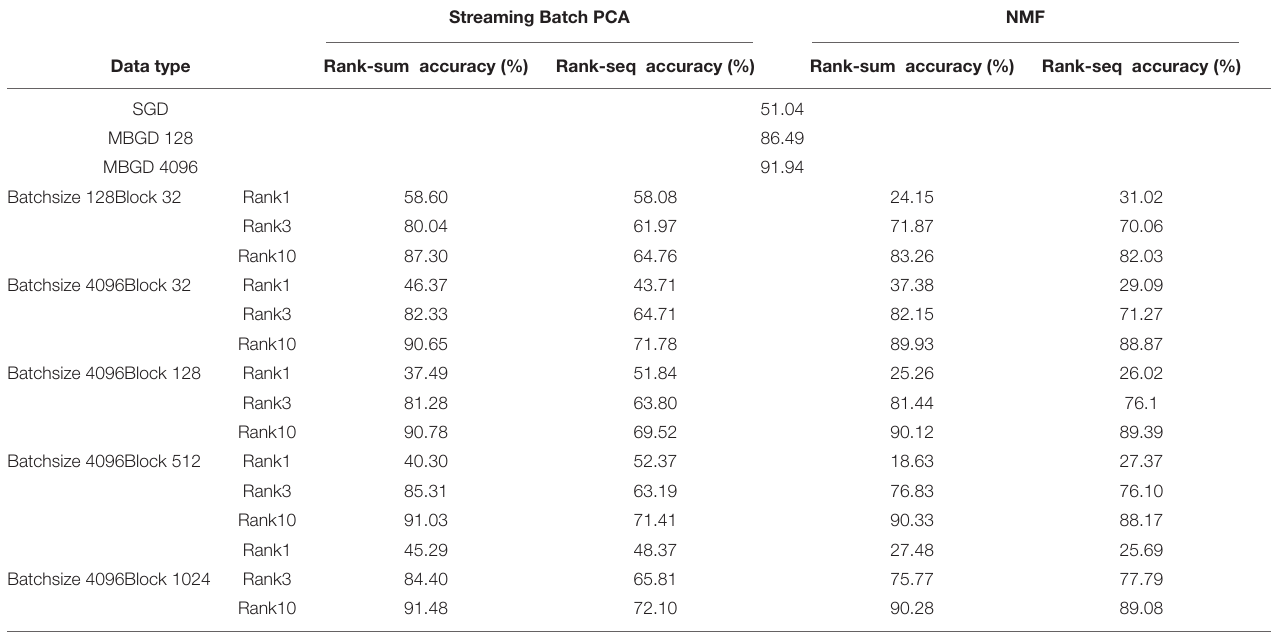
TABLE 2 | Summary of the best results for different ranks, batch sizes and truncation methods for streaming batch PCA vs. NMF. Streaming Batch